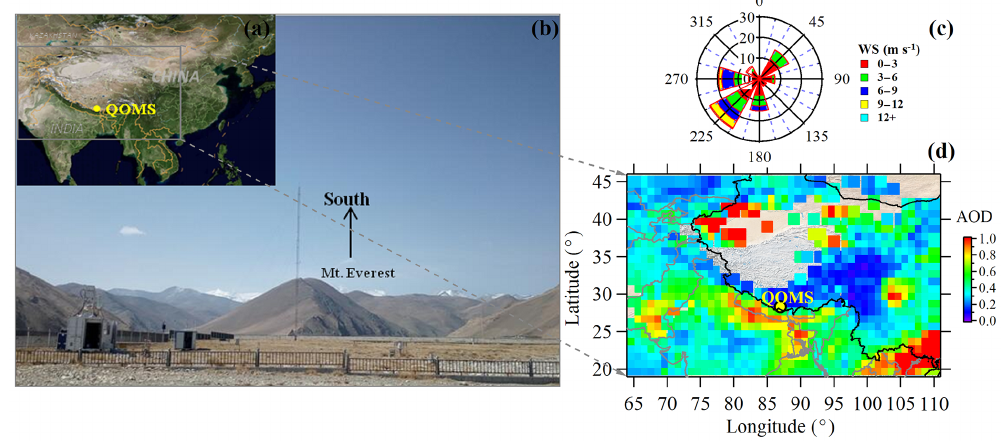
Figure 1. (a) Map of the QOMS location, (b) picture of the QOMS and its surrounding, (c) wind rose plot colored by wind speed in this study, and (d) distribution of the average aerosol optical depth (AOD) around the QOMS retrieved from Terra MODIS at 550nm during this